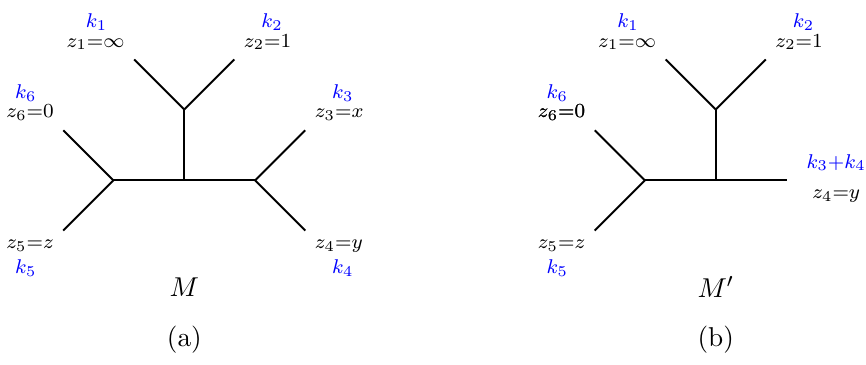
Figure 2 . Feynman diagrams in the recurrence relation for an N = 6